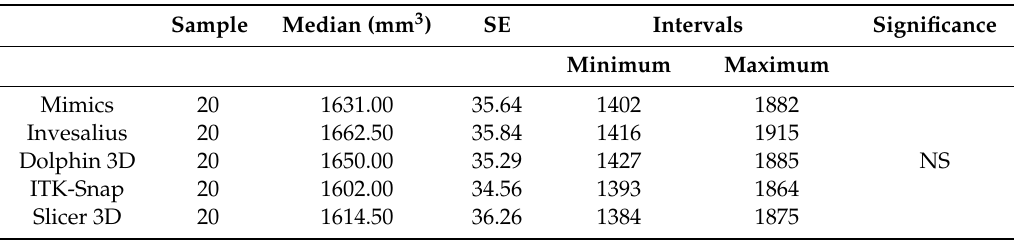
Table 2. Comparison among the volumetric measurements of the condylar 3D models obtained with the tested software. Significance set at p < 0.05, based on Kruskal–Wallis test; SE = standard error, NS = not